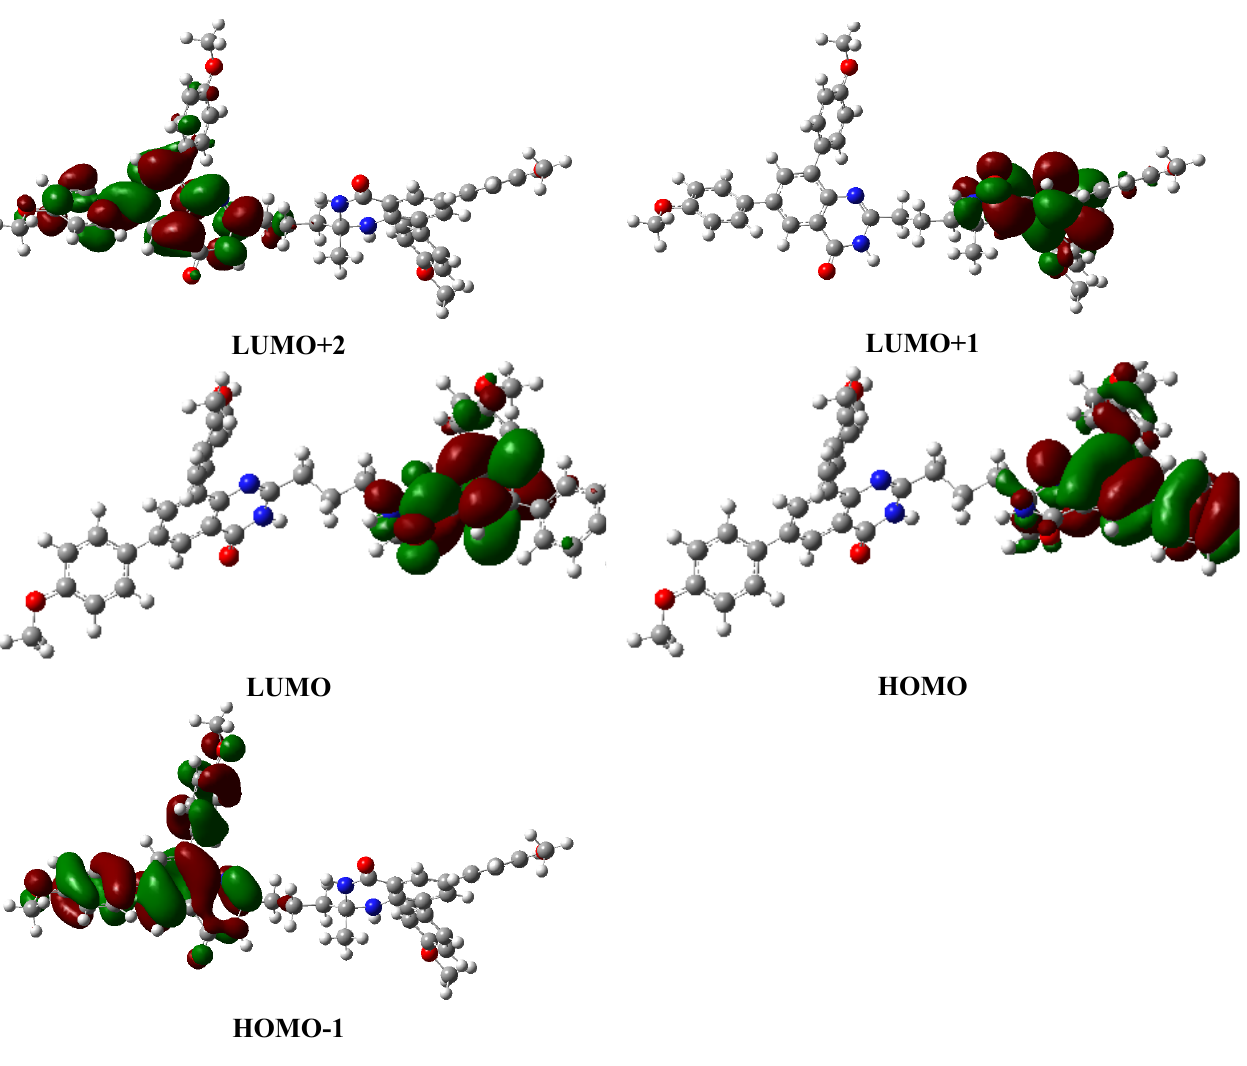
Figure 11. Orbital topology for 4c as representative